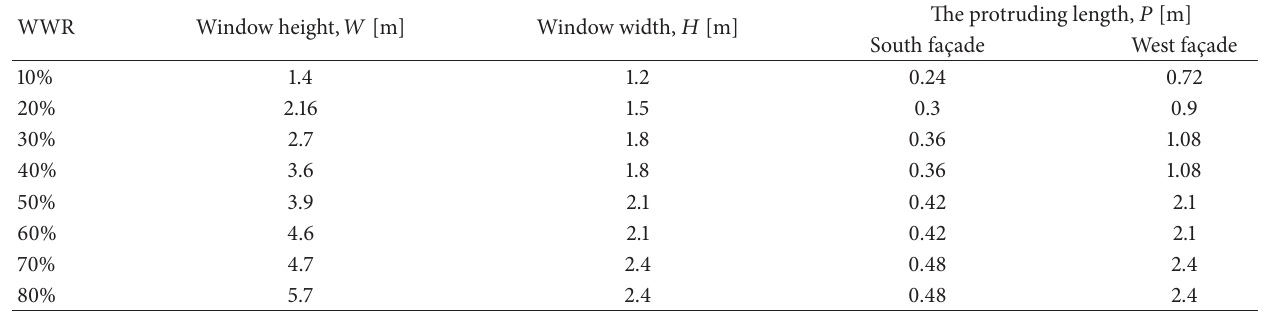
Table 3: Protruding lengths of horizontal shading devices in the south and west